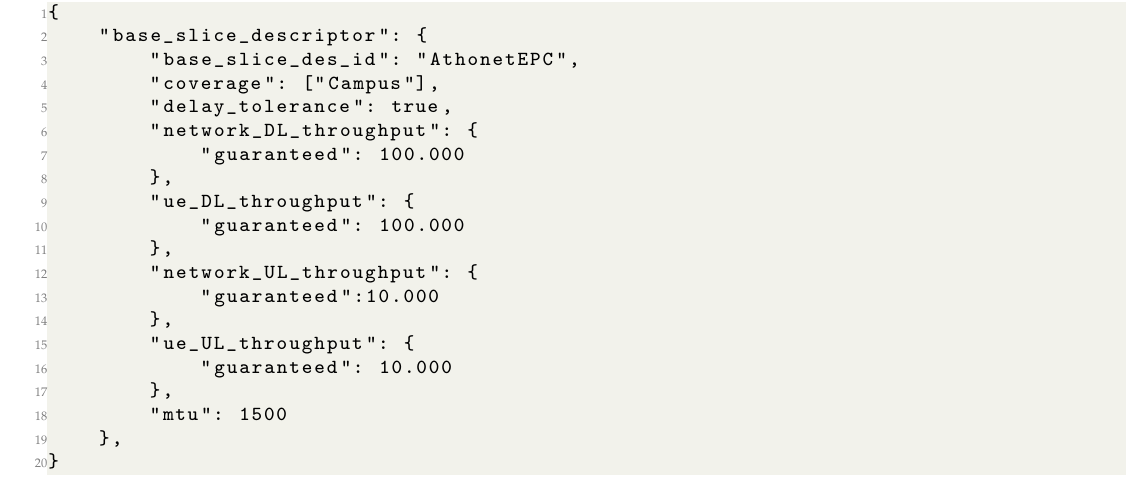
Listing 1. Instantiation of the Generic Network Slice Template. Throughput and Maximum Transfer Unit (MTU) values are given in kbps and bytes,